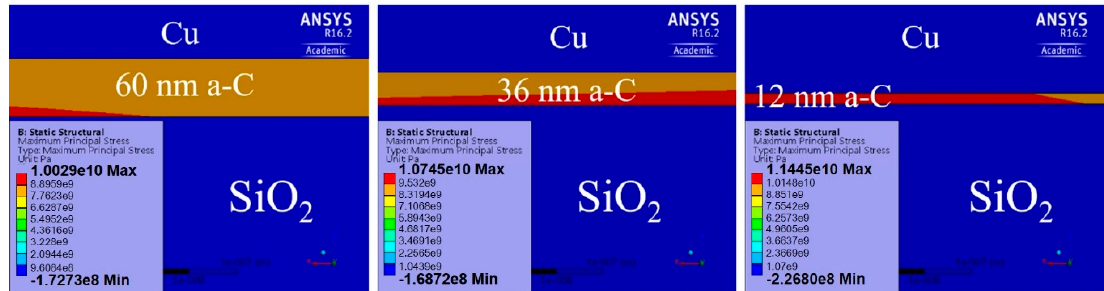
Figure 5. ANSYS simulation of thermo-mechanical stress (equivalent von-Mises stress) at the a-C and Cu interface at 1020 °C.